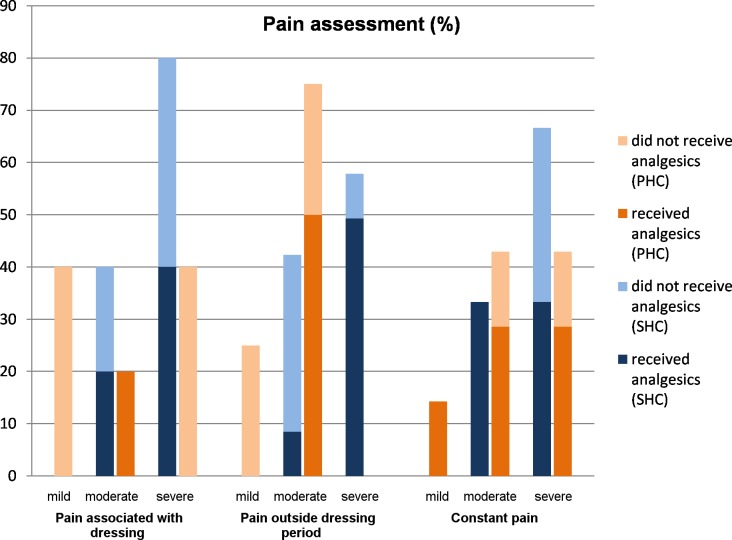
Pain assessment in BU patients with IS2404 PCR positive ulcers enrolled at the PHC and the SHC centers.